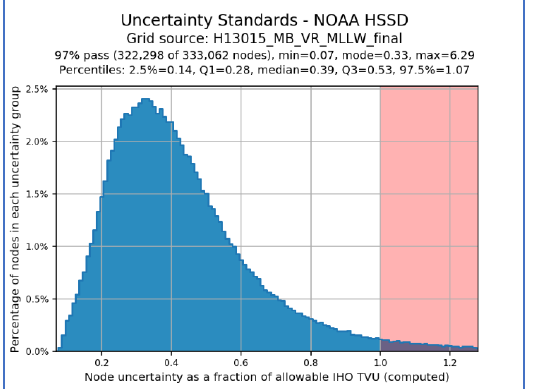
Figure 8. Grid QA output for uncertainty. The histogram illustrates the percentage of total nodes that contain a node uncertainty as a fraction of the International Hydrographic Organization’s Total Vertical Uncertainty. As such, the histogram bins over 1.0 (in red) do not pass uncertainty requirements.